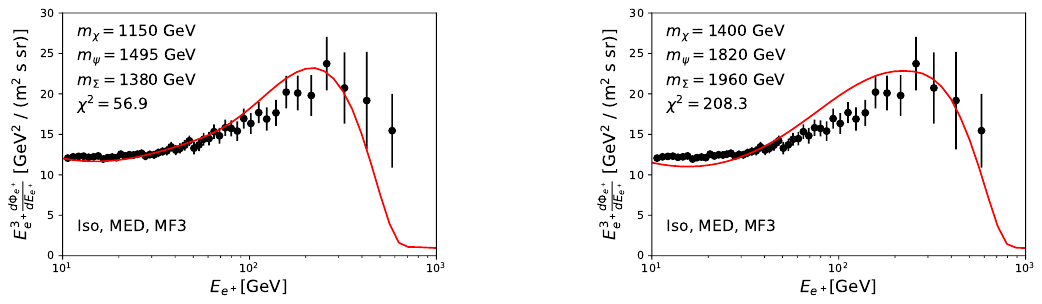
Figure 3 . The best (cid:12)t spectra for the S2B (left) and 3B (right) cases. The points mark the AMS data with error